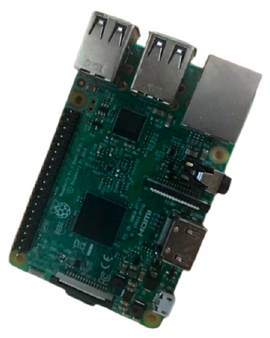
Figure 11. Raspberry Pi 3 Model B board.